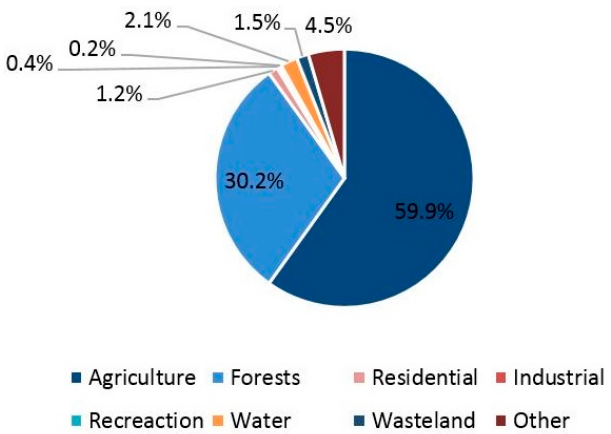
Figure 1. Land use in Poland, 2021, data obtained from [66].